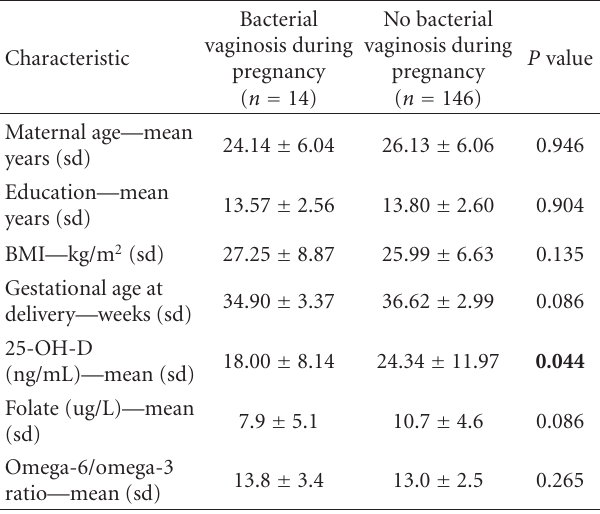
Table 1: Characteristics of women with and without bacterial vagi- nosis during